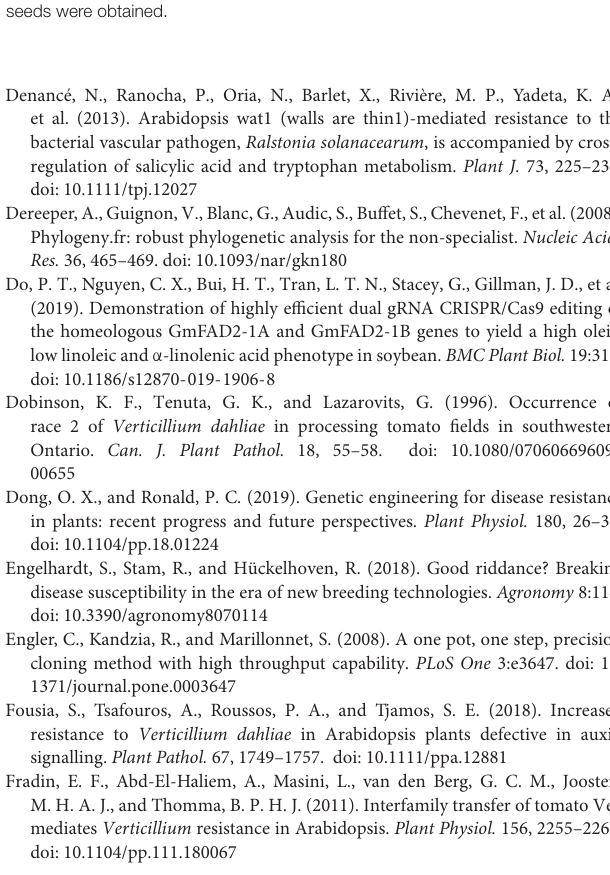
Supplementary Figure 1 | Gel electrophoresis (1% TBE, Gelred, image colors inverted) of gene-specific PCR with primers KH_156 on primary transformants (T1) of plants transformed with SlWAT1 CRISPR-Cas9 construct. Wild-type PCR product (1,616 bp) indicated with an arrow and highlighted are mutants #10, #19, #23, and #28 that were transferred to the greenhouse, and of which seeds were only obtained from #19 (TV181046). Supplementary Figure 2 | Predicted transmembrane domains for wild-type SlWAT1 (left), mutant allele 1 (right), and mutant allele 2 (bottom). Graphs were generated with TMHMM Server v. 2.0 (http://www.cbs.dtu.dk/services/TMHMM/). Supplementary Figure 3 | CRISPR T2 family TV181046 and its T3 progeny TV181046-16, –18, and –23 display severe growth and development defects. Pictures of MM and T3 CRISPR WAT1 plants at different time points. Supplementary Figure 4 | Canopy area pictures mock- and V. dahliae- inoculated (strain JR2) plants for CRISPR T2 family TV181046 and T3 families TV181046-16, –18, and –23 at 21 dpi compared to MM plants of respective experiment. Supplementary Table 1 | Primers used in this study. Supplementary Table 2 | Overview of primary transformants (T1) with presence/absence of silencing construct (NPTII/35S), relative SlWAT1